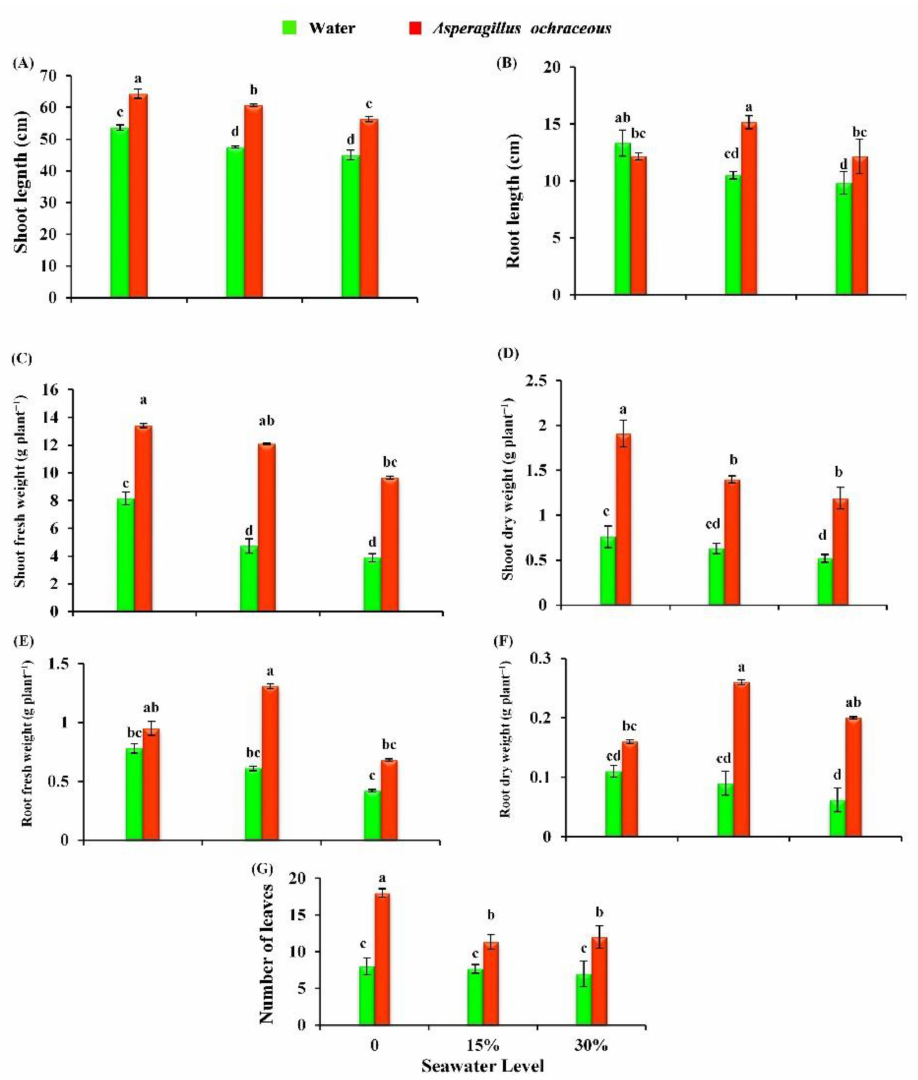
Figure 4. Effect of seawater irrigation, A. ochraceus application, and their interactions on the mor- phological parameters of barley plants {( A ) shoot length, ( B ) root length, ( C ) shoot fresh weight, ( D ) shoot fresh weight, ( E ) root fresh weight, ( F ) root dry weight, and ( G ) number of leaves}. Each bar represents the mean ± standard error. Different letters indicate significant differences between the treatments according to an LSD test at p <